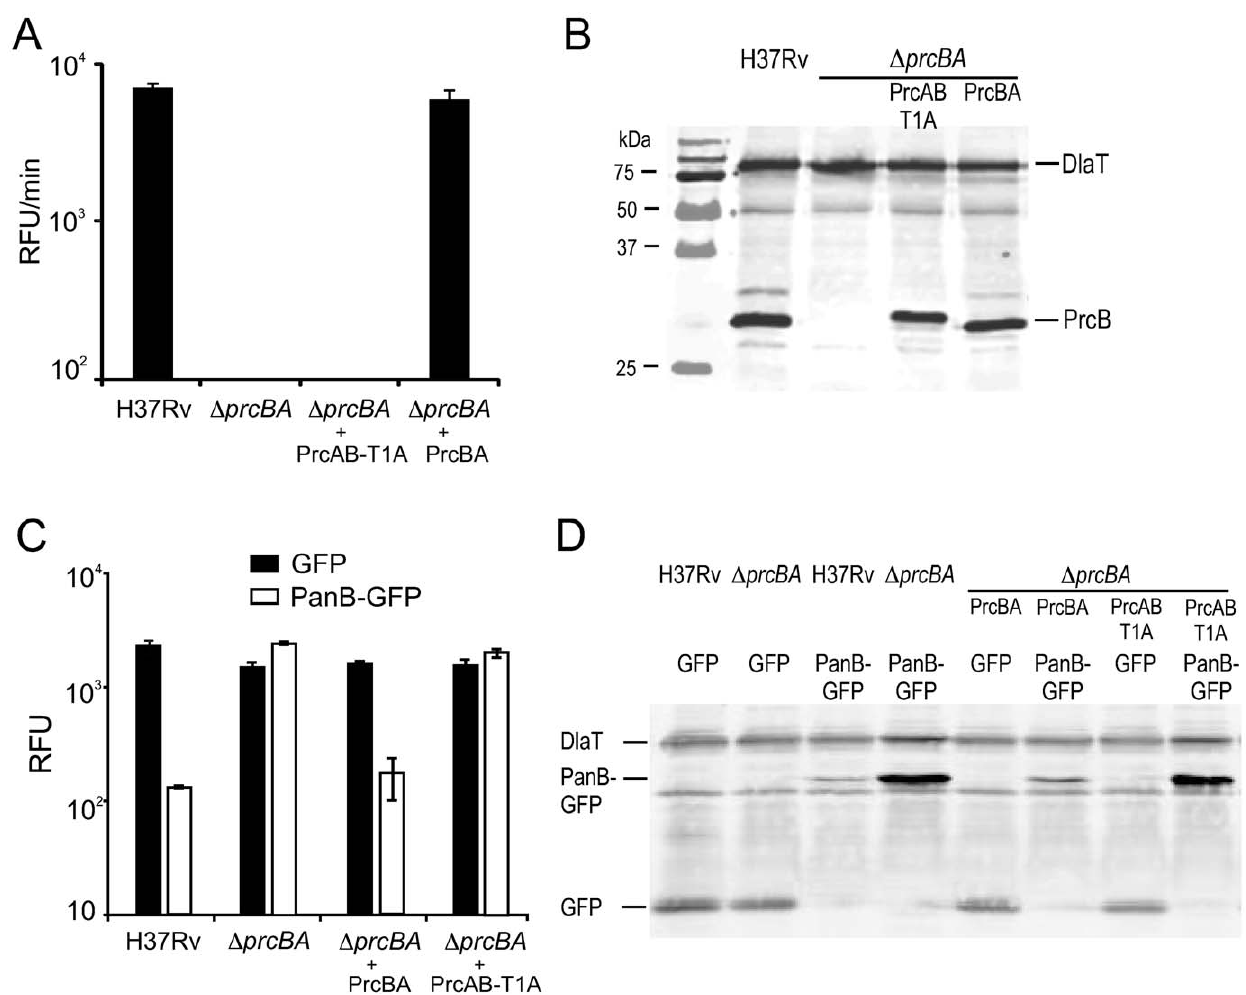
Figure 3. Characterization of the active site mutant proteasome. ( A ) Proteasome activities of H37Rv, D prcBA and D prcBA complemented with the active site mutant proteasome (PrcAB-T1A) and the intact proteasome (PrcBA) measured using the fluorogenic substrate Suc-LLVY-AMC. Proteasome activity was not detectable in D prcBA and D prcBA complemented with the active site mutant proteasome (PrcAB-T1A). ( B ) PrcB levels analyzed by immunoblotting in lysates from H37Rv, D prcBA and the complemented strains. DlaT was used as loading control. ( C ) GFP activities in strains expressing GFP or the PanB-GFP fusion protein. ( D ) GFP and PanB-GFP levels analyzed by immunoblotting in lysates from H37Rv, D prcBA and the complemented strains. DlaT was used as loading control.